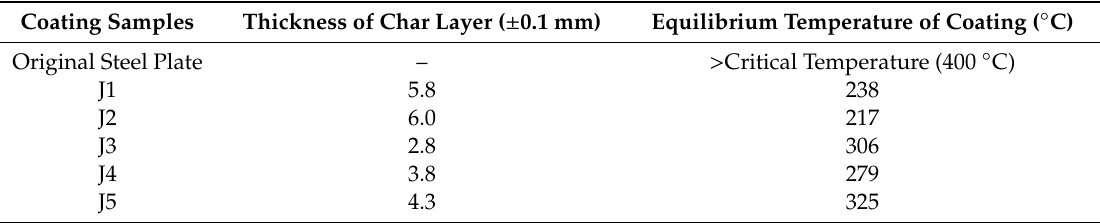
Table 3. Thickness of char layer and the equilibrium temperature of coated